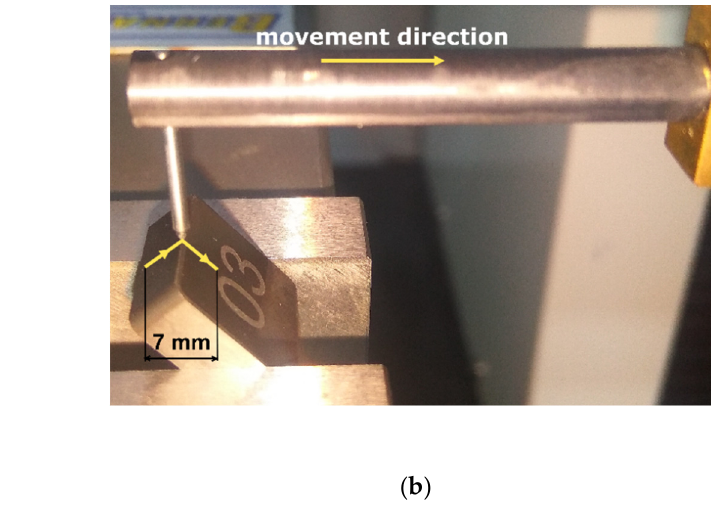
Figure 6. Contour measuring device: ( a ) Surfcom 5000, ( b ) measuring process [16].